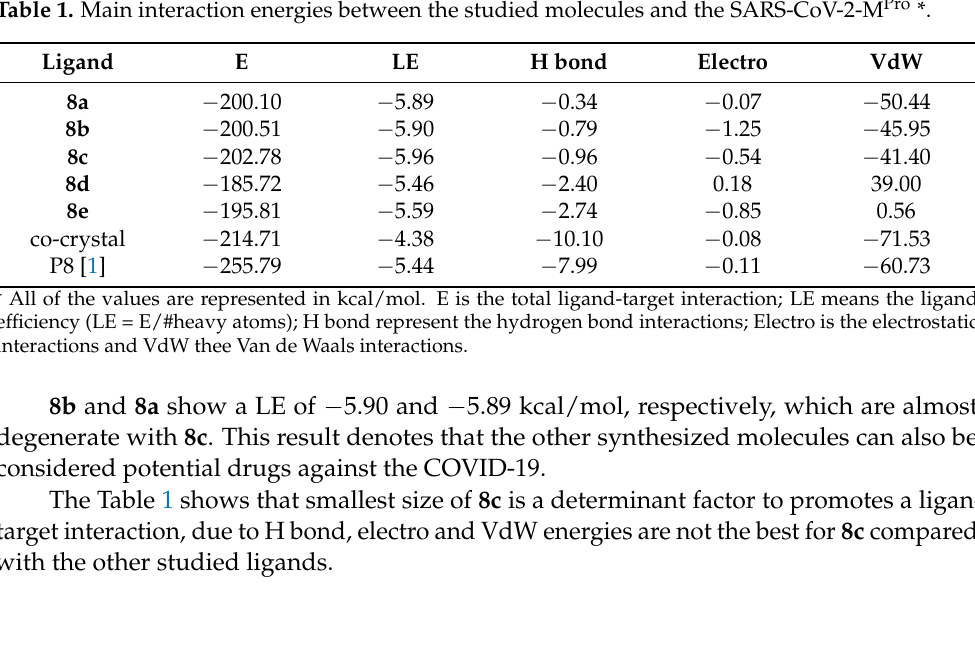
Figure 3. Molecular docking of the synthesized novel bis -furanyl-pyrrolo[3,4- b ]pyridin-5-ones and two reference molecules.